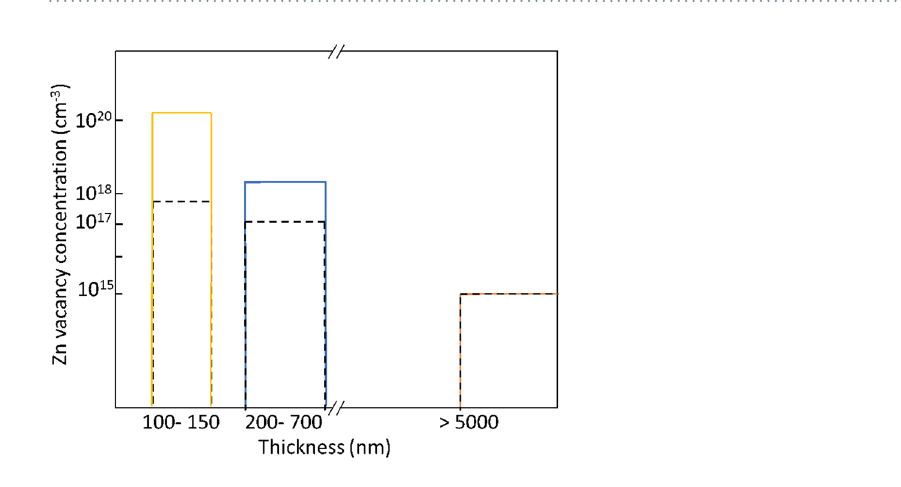
Figure 3. Schematic for the zinc vacancy concentration profile after oxygen annealing the CVT crystal at 1100 °C (broken lines) and 1200 °C (solid lines) (not to scale) 6